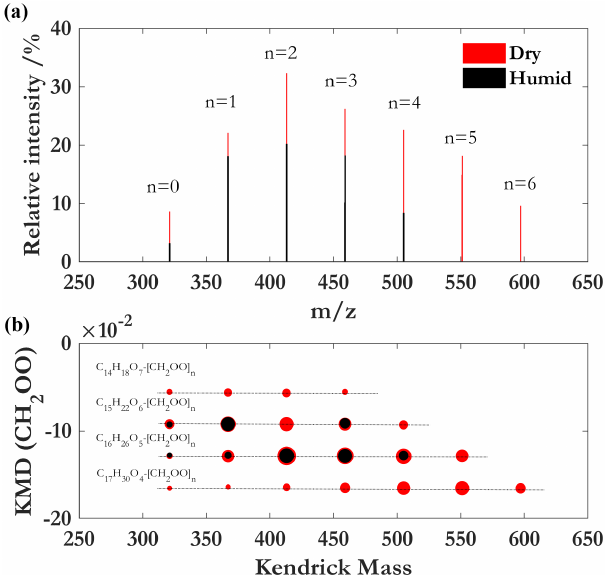
Figure 12. Mass spectra of oligomers with C 4 H 6 O 2 (MACROO and MVKOO) as the repeating unit and their Kendrick plots us- ing C 4 H 6 O 2 as the Kendrick base. Species separated by C 4 H 6 O 2 groups fall on the horizontal